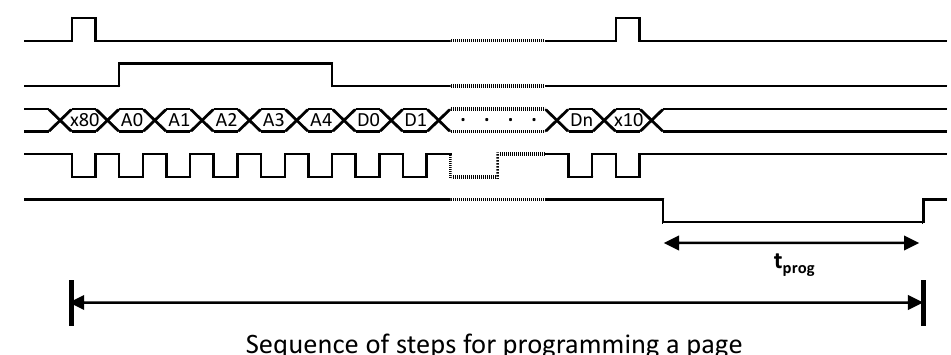
Figure 3. Timing diagram for a sequence of steps carried out by the host during the page program operation in an asynchronous interface.